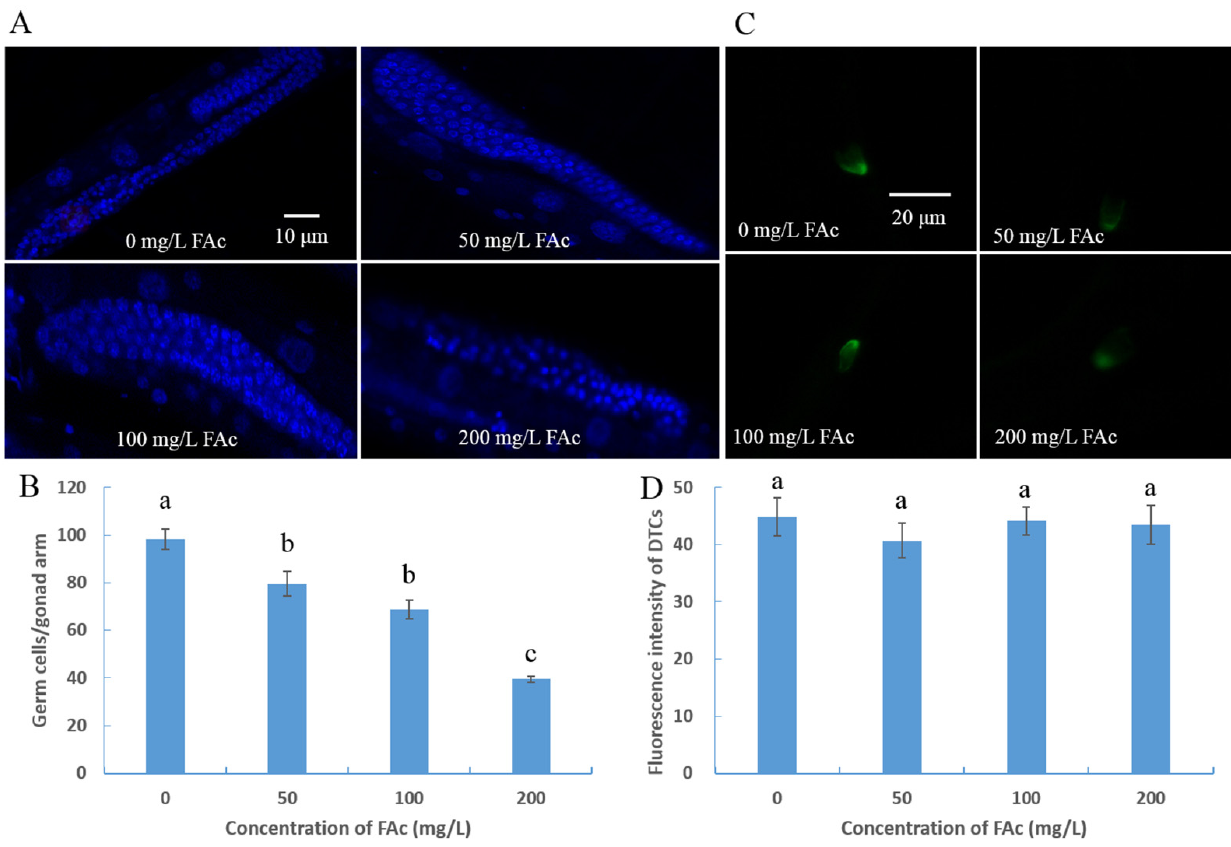
Figure 3. FAc-induced nematode germ-cell reduction. ( A ) Images of germ cells of C. elegans , wild-type L4 worms were treated with FAc in different concentrations for 24 h, and stained by using DAPI. The bar denotes 10 μ m. ( B ) Number of germ cells of C. elegans after exposure to FAc for 24 h; data are shown as mean ± standard error ( n ≥ 10). ( C ) Images of distal tip cells (DTCs) of JK2868 nematodes after exposure to different concentrations of FAc. The bar denotes 20 µ m. ( D ) Fluorescence intensity of DTCs of JK2868 nematodes exposed to different concentrations of FAc. Data are shown as the mean ± standard error ( n ≥ 11), and different lowercase letters indicate significant difference among treatments by LSD test ( p < 0.05).